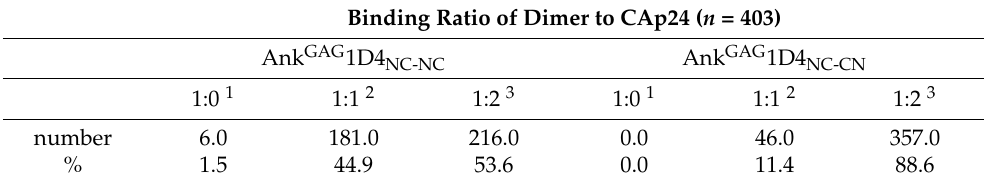
Table 1. Frequency of binding ratio of one dimer to CAp24 molecule(s).